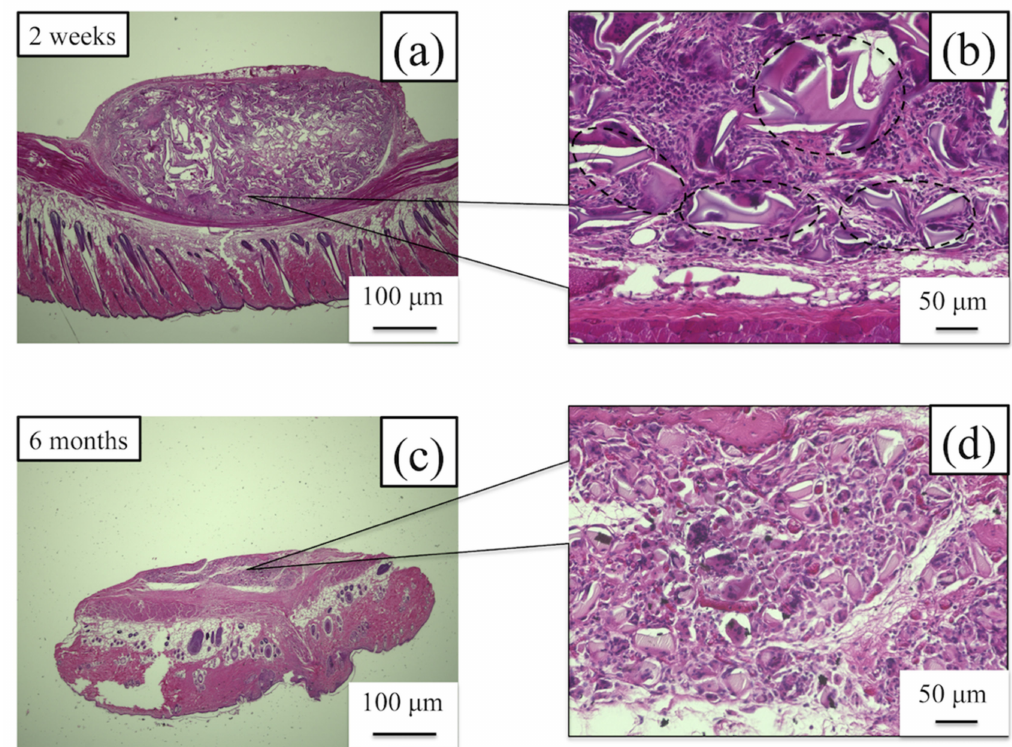
Figure 10. Histological images of hematoxylin and eosin staining 2 weeks after implantation of the ( a ) PU-SF sponge and ( b ) higher magnification of the PU-SF sponge. Histological images of hematoxylin and eosin staining 6 months after implantation of ( c ) the PU-SF sponge and ( d ) higher magnification of the PU-SF sponge. The part enclosed by the dotted line shows the SF sponge. At 2 weeks after implantation, inflammatory cells gathered in the gaps of the SF sponge were confirmed. In addition, the SF sponge was further decomposed 6 months after